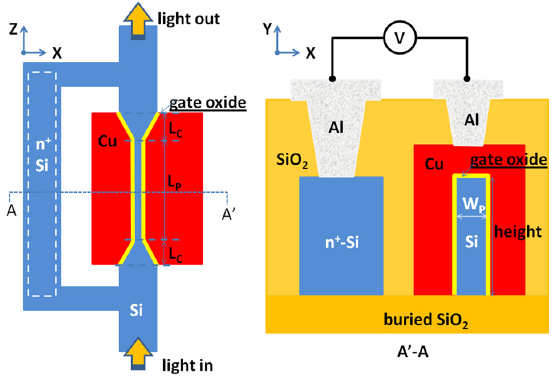
Figure 5: Schematic view of the horizontally arranged silicon-based plasmonic electro-absorption modulator. Copyright (2011), AIP Pub- lishing LLC, from Ref. [134], with permission of the authors.